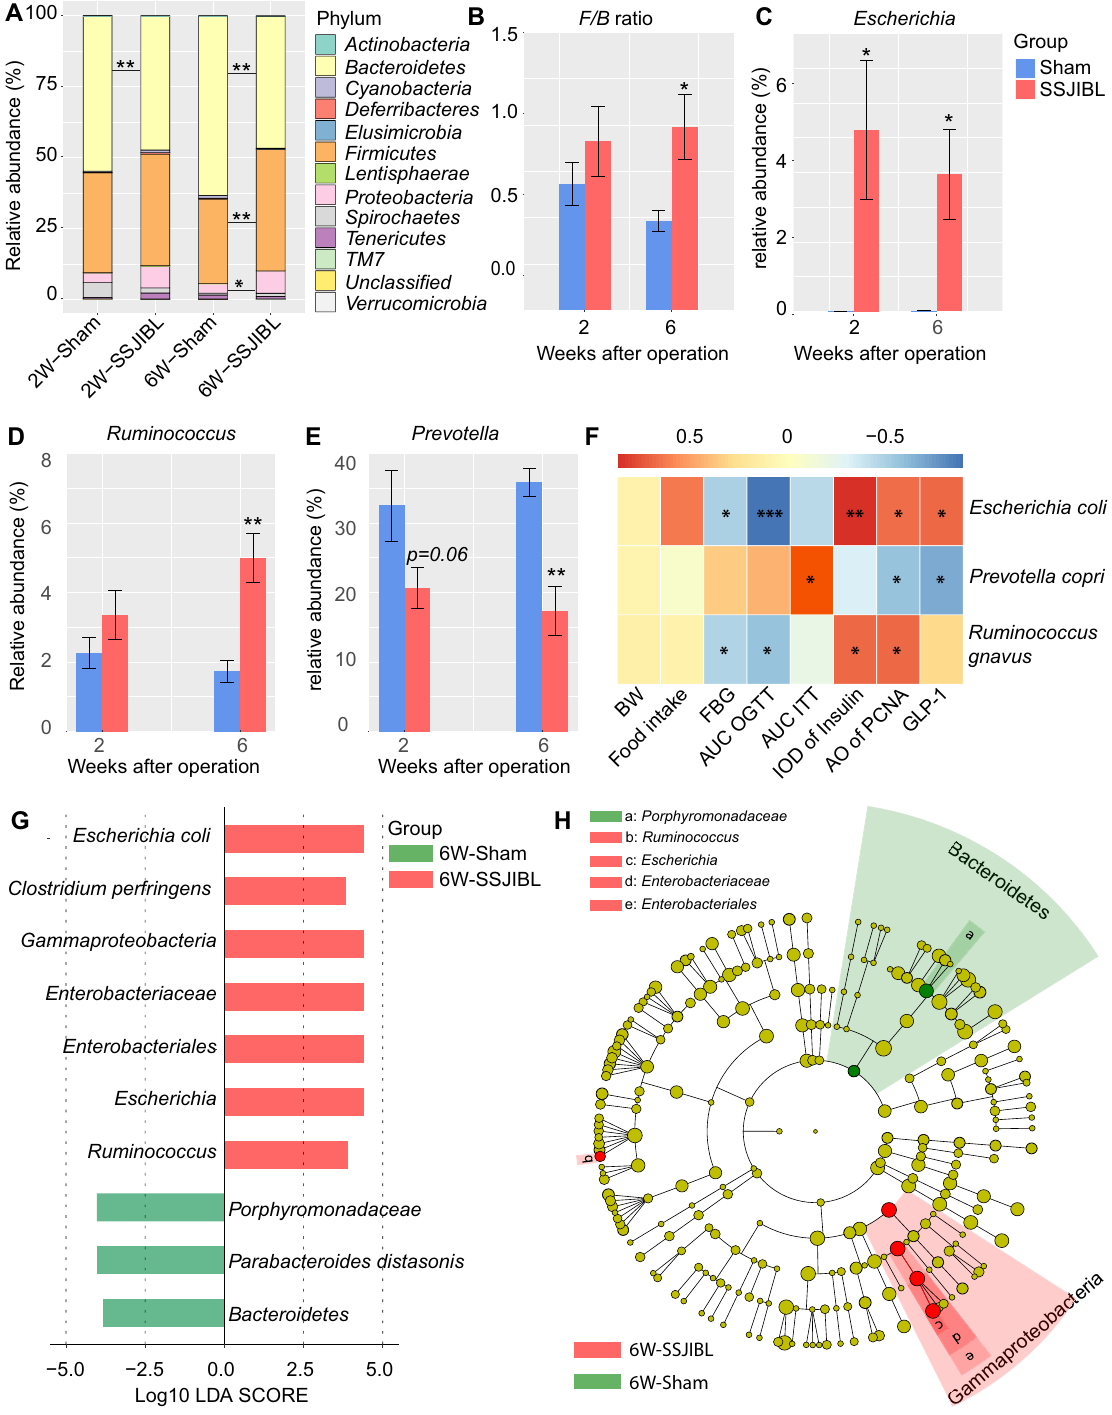
Figure 4. SSJIBL up-regulated gut Escherichia and Ruminococcus and down-regulated Prevotella in GK rats. ( A ) Bacterial taxonomic profiling at the phylum level of intestinal bacteria from two groups 2 weeks and 6 weeks postoperation. ( B ) Firmicutes -to- Bacteroidetes ratio in the indicated groups. ( C – E ) Bacterial taxonomic profiling at the genus level of intestinal bacteria from two groups 2 weeks and 6 weeks postoperation. ( F ) Heatmap analysis of the Pearson correlation of Escherichia coli , Ruminococcus gnavus and Prevotella copri and glucose homeostasis-related indexes. Red represents positive correlation, and blue indicates negative correlation. ( G ) A linear discriminant effect size (LEfSe) analysis was performed (alpha value ≥ 0.05, logarithmic LDA score threshold ≥ 3.0) on two groups together. ( H ) The cladogram represents the phylogenetic relationship of significant OTUs associated with each group. Error bars are expressed as means ± SEM. Statistical significance was determined by two-tailed Student’s t test. * P < 0.05, ** P < 0.01, and *** P <